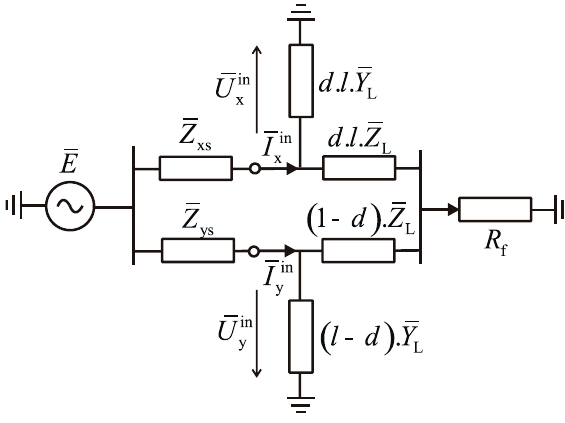
Figure 5 . A simplified equivalent circuit for a single-phase fault. Figure 5. A simplified equivalent circuit for a single-phase